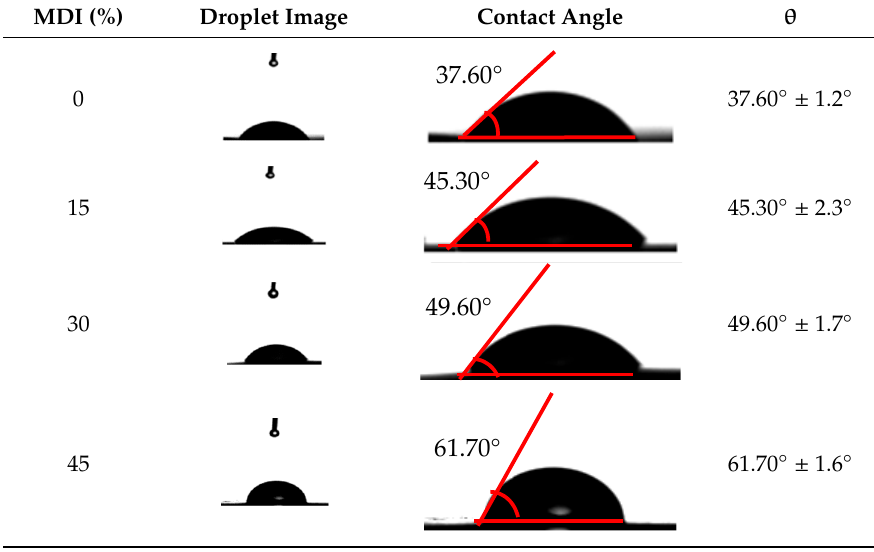
Table 3. Tensile strength and elongation percentage of the CA–PUs.